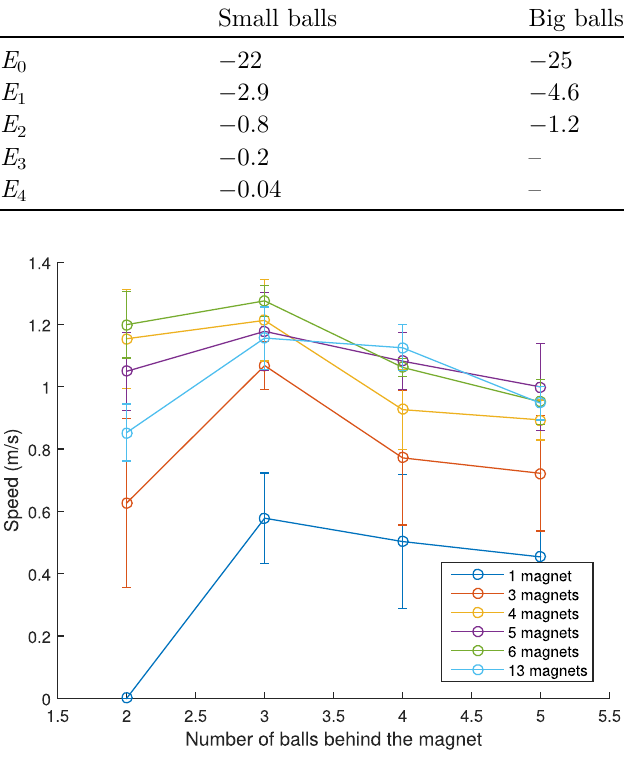
Fig. 5. Ejection velocities v 1 for small balls with a v 0 as small as possible, as a function of the number of balls and